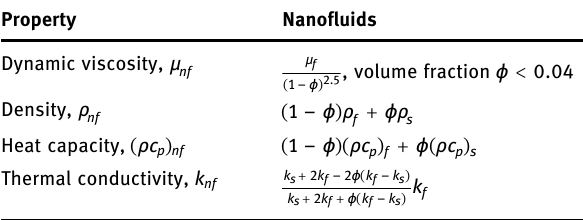
Table 1: Thermophysical properties of the base fl uid and nanoparticles at 20°C [ 80,86, 101,125, 134 ]